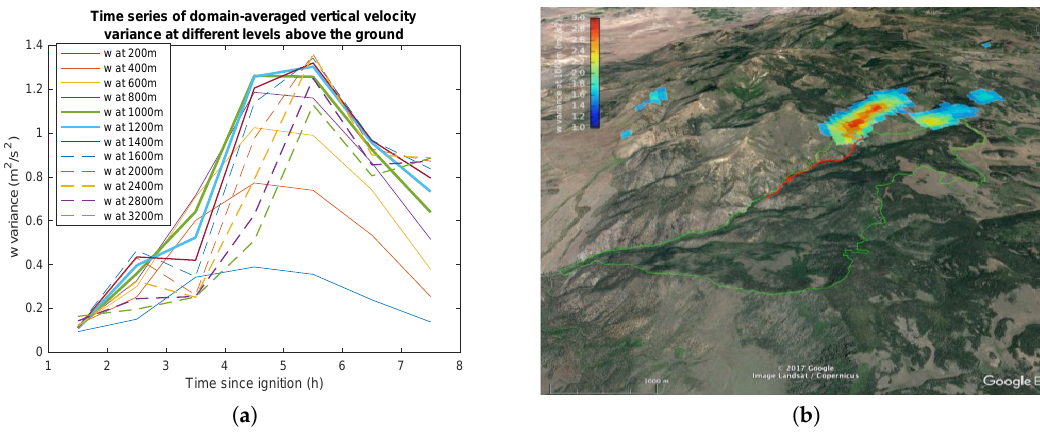
Figure 13. ( a ) The time series of the variance of vertical velocity at different heights above the ground from simulations executed with parameters from the rLHS sampling; ( b ) Map of the variance of the vertical velocity at 1200 m with the indication of the burn plot (green contour) and the ignition (red